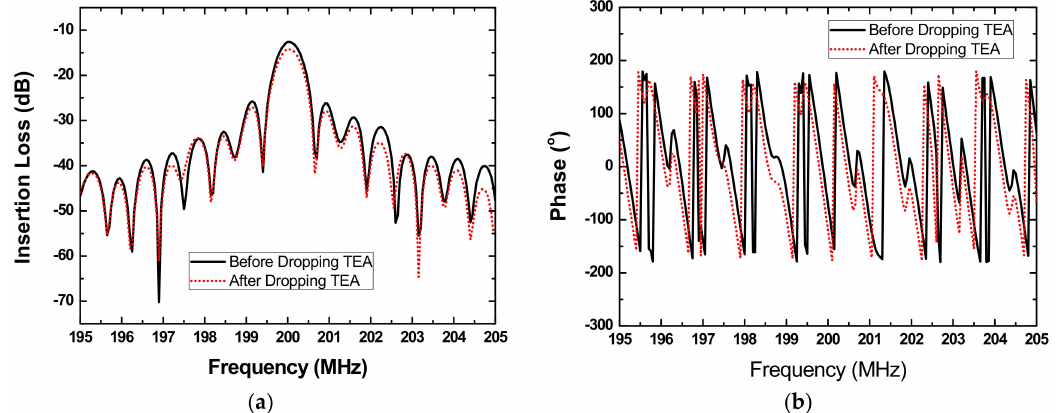
Figure 3. The measured insertion loss ( a ) and phase ( b ) of the proposed sensing device before and